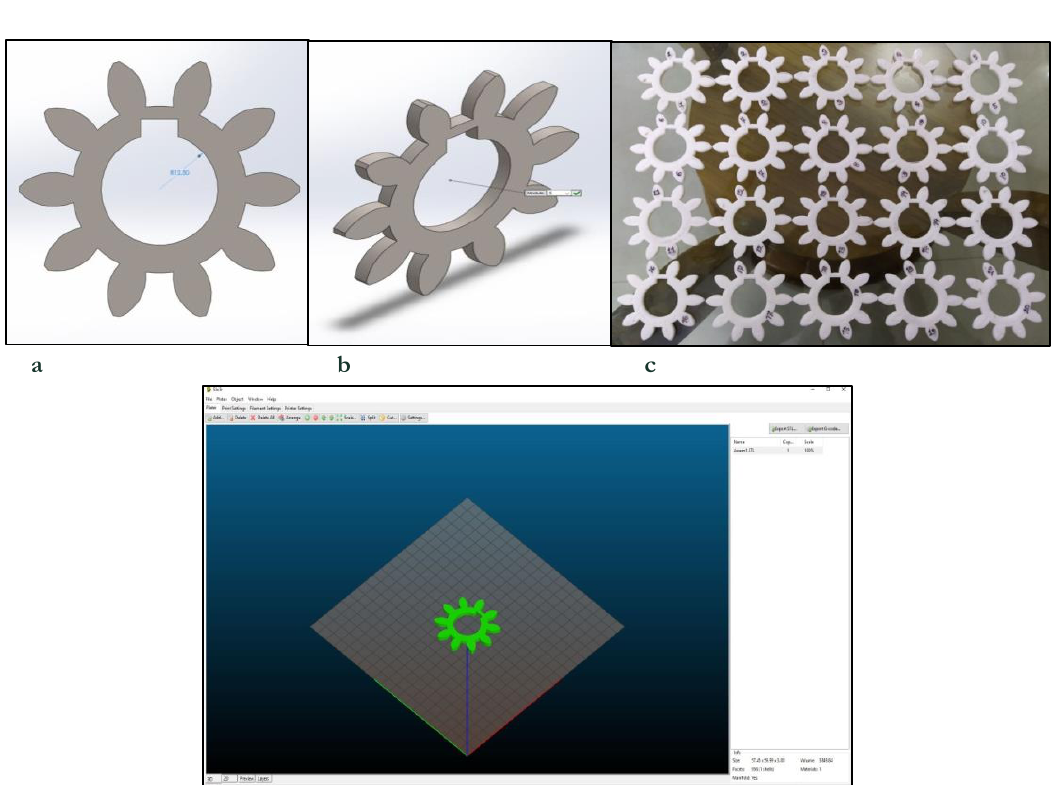
Fig. 2. a. Dimension of the test specimen; b. 20 3D printed spur gears; c. conversion of CAD model into G-code through Slic3r